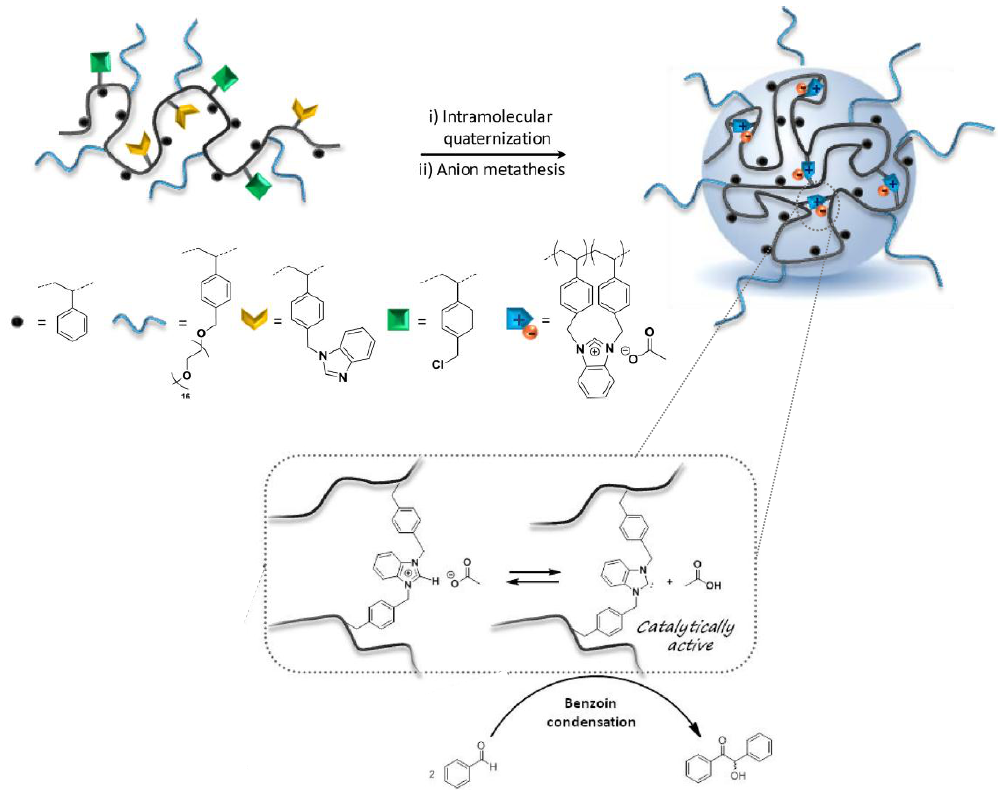
Figure 10. Schematic illustration of the formation of imidazolium acetate-containing SCNPs via intramolecular quaternization and anion metathesis from a statistical copolymer composed of four different comonomer units, including styrene, grafted poly(ethylene oxide) chains, and antagonist benzimidazol- and chlorobenzyl-based units, and the use of these SCNPs for the organocatalyzed benzoin condensation (adapted from [51] with permission, Copyright American Chemical Society, 2017).